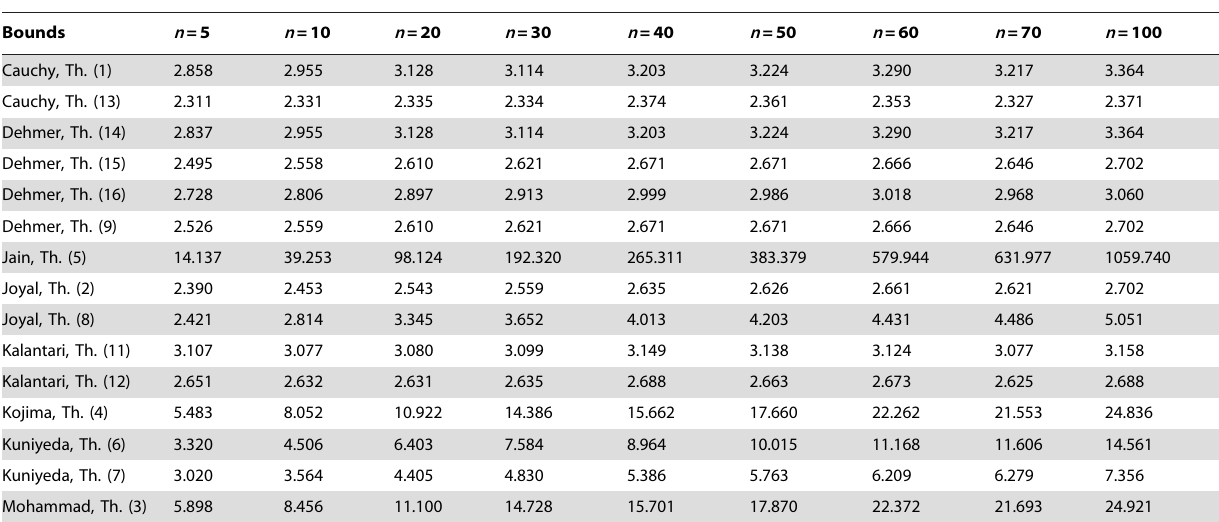
Table 2. Mean bounds values for polynomials P i [ C 2 .